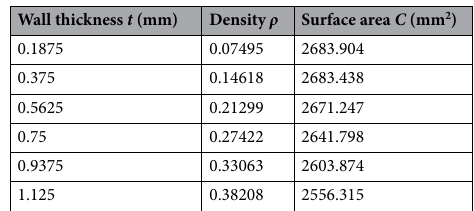
Table 3. Parameters of compression model with different wall